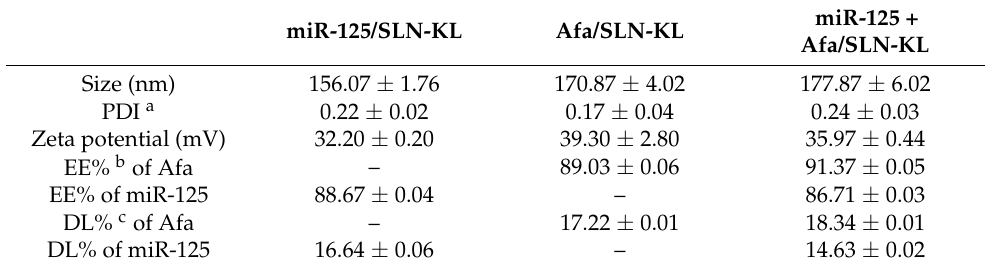
Table 1. Characterization of various